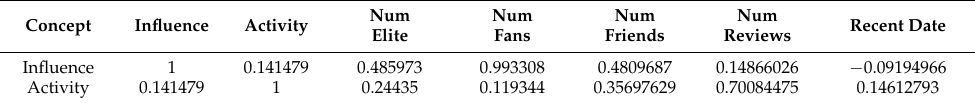
Table 4. Correlations between user influence, user activity, and the Yelp